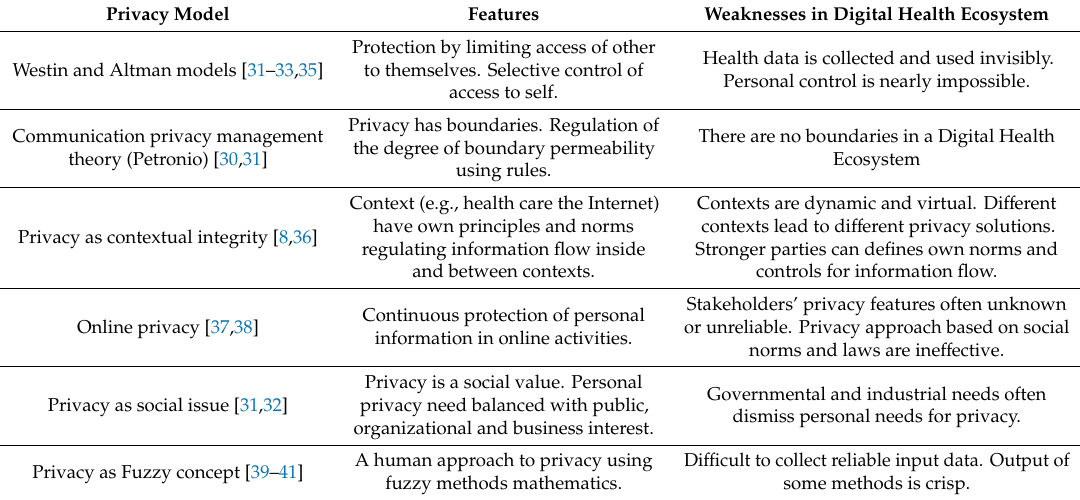
Table 2. Common privacy models and their